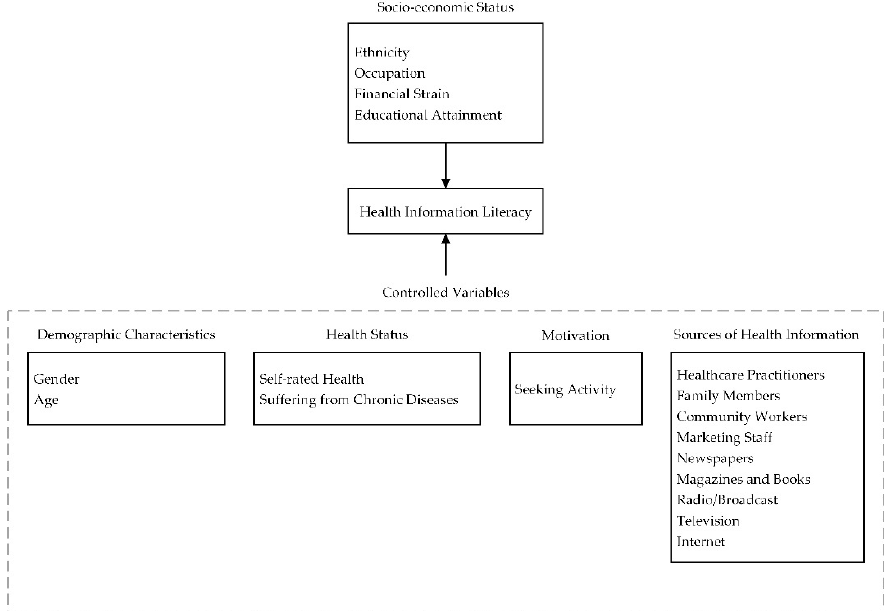
Figure 1. The conceptual model.